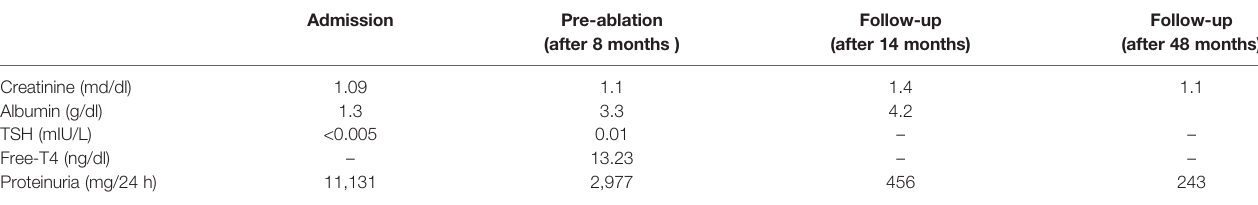
TABLE 1 | Follow-up of patient ’ s laboratory